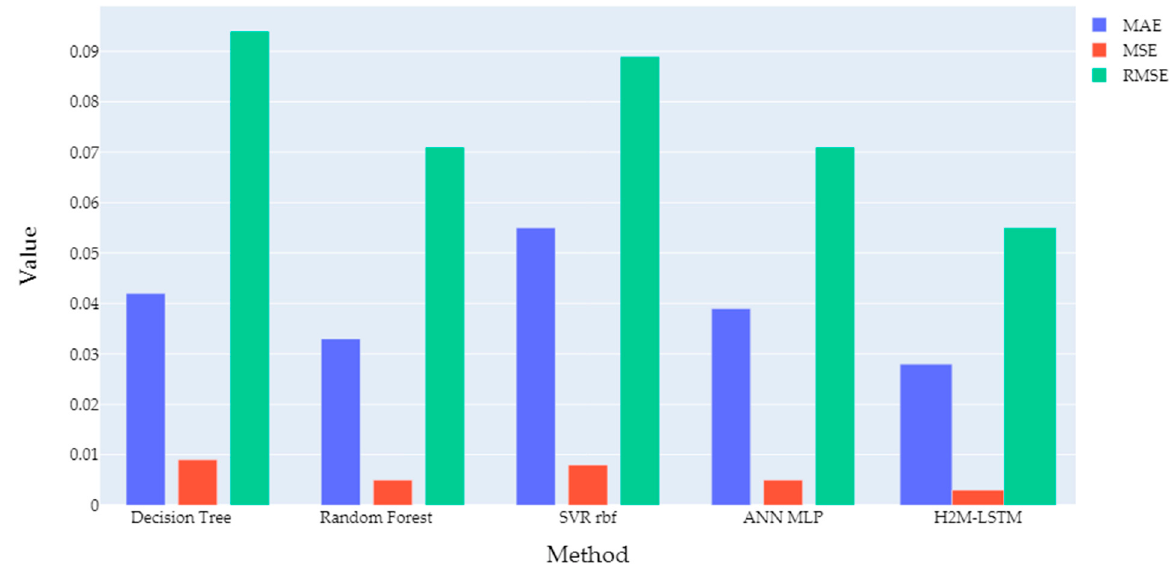
Figure 12. Barplot comparison of the best performance metrics for the heat storage tank.